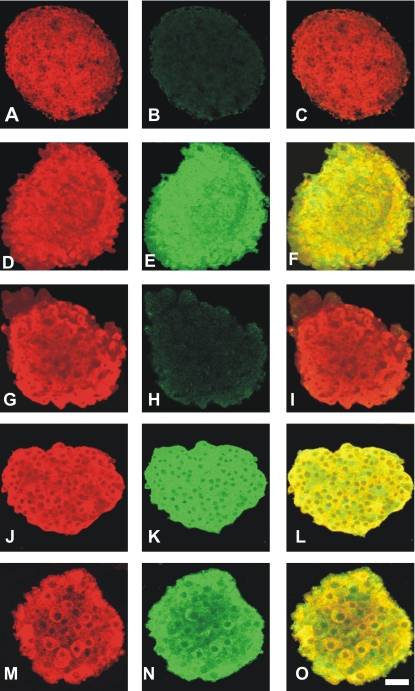
Confocal microscopy of mouse islets.Isolated islets were cultured for 24 h at a basal glucose concentration of 5 mmol/l (A–C); 5G+palmitate (1 mmol/l) (D–F); 5G+palmitate+rosiglitazone (1 μmol/l) (G–I) or 20G (J–L) and 20G+rosiglitazone (1 μmol/l) (M-O). After the culturing period the islets were double-immunolabelled for insulin (appears as red) (A, D, G, J and M) and iNOS (appears as green) (B, E, H, K and N) and analyzed by confocal microscopy. Co-localization of insulin/iNOS is seen as a yellowish fluorescence (C, F, I, L and O). Fluorescence intensity data of iNOS (green) were normalized to 100% as measured in E (5G+palmitate) and gave the following results (n = 12). B = 1.50±0.75; E = 100.6±2.52; H = 4.33±1.50; K = 99.0±2.96; N = 106.1±3.22.